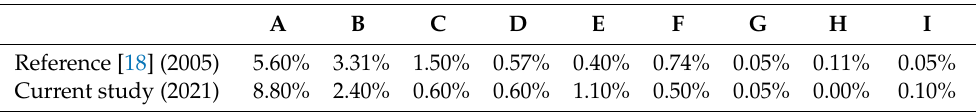
Table 6. Comparative analysis of the frequency and variability of compound word problems with additive